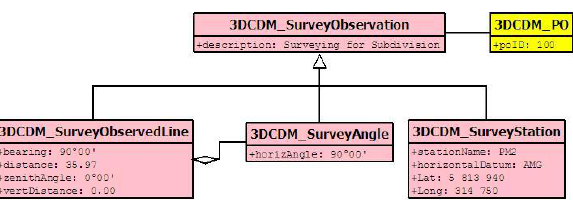
Figure 22. Instance of 3DCDM_SurveyObservation